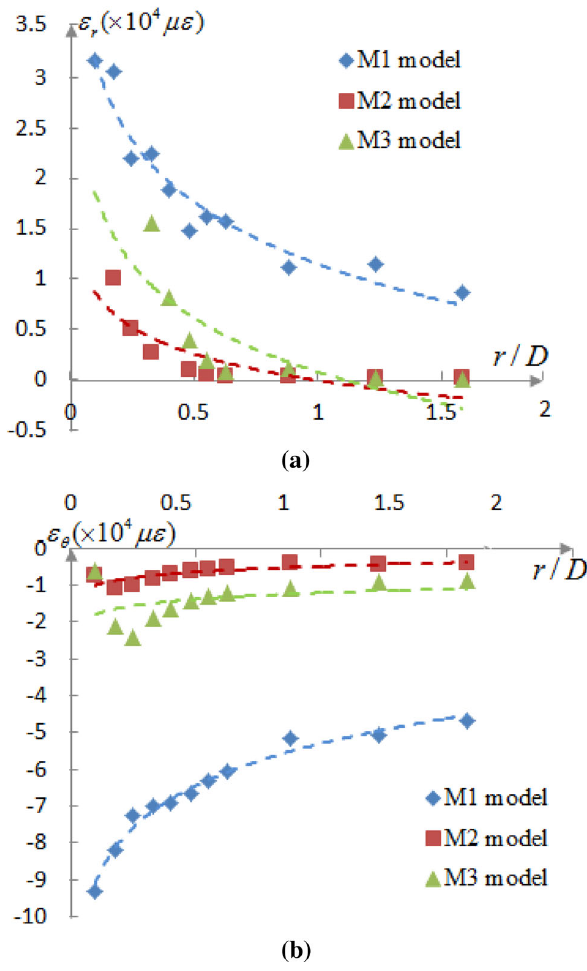
Fig. 12 Comparative analysis of the a radial and b circumferential strains in the middle part of side walls in the three models after